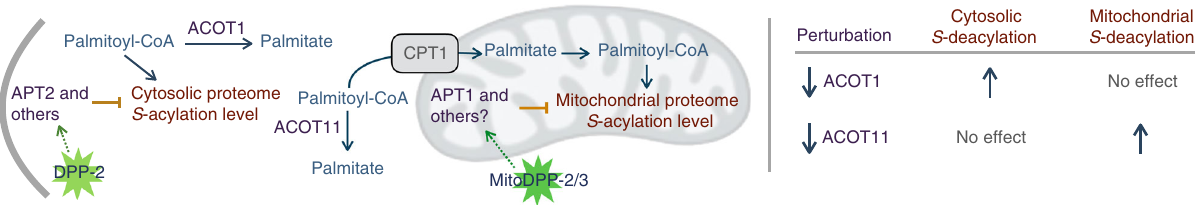
Fig. 10 Schematic of results from this study. Of the identi fi ed APTs, APT1 localizes predominantly to mitochondria, whereas APT2 is found in the cytosol. Cytosolic vs. mitochondrial APT activity can be differentially increased by knockdown of ACOT1 or ACOT11,